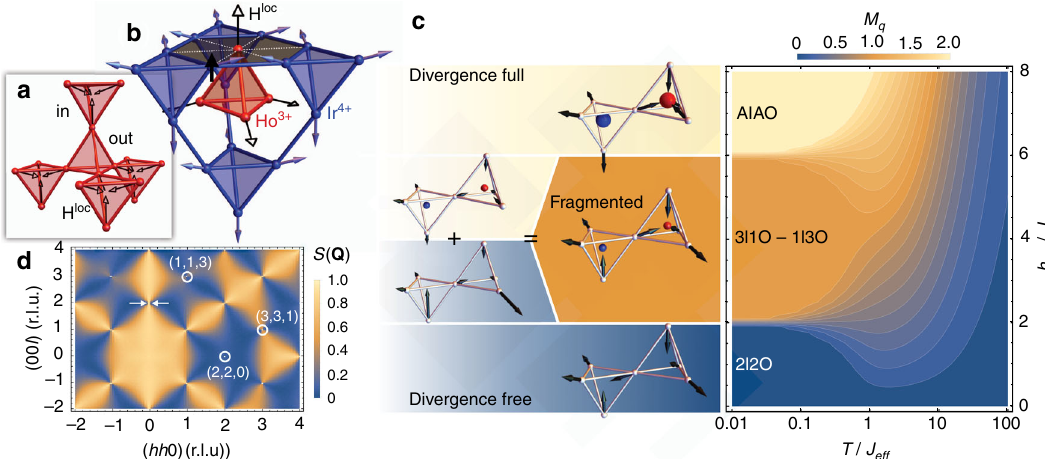
Fig. 1 Staggered fi eld in a pyrochlore lattice and magnetic fragmentation. a Pyrochlore lattice submitted to 〈 111 〉 staggered fi eld represented by the arrows on each site, with in and out tetrahedra when this fi eld points either inward or outward of the tetrahedra. b Structure of the pyrochlore iridate Ho 2 Ir 2 O 7 with the Ho 3+ ions ( red ) and the Ir 4+ ions ( blue ), both occupying a pyrochlore lattice. Each rare-earth is surrounded by a hexagon of six Ir nearest neighbors. When the iridium lattice orders magnetically in the AIAO phase, as shown on the blue lattice , a local magnetic fi eld, perpendicular to the hexagon plane, hence aligned along the local 〈 111 〉 directions, is felt by the central rare-earth ion, as represented in a . c Phase diagram as a function of reduced temperature T = J eff and local fi eld h loc = J eff , de fi ned through the charge order parameter M q ¼ 1 tetrahedra and Δ α = +1 ( − 1) for in (out) tetrahedra carrying a charge q α . As h loc = J eff increases, the ground state changes from the spin ice ( M q = 0, blue ), to the AIAO state ( M q = 2, yellow ), going through the charge crystal intermediate phase which fragments ( M q = 1, orange ). The fragmentation can be described by the splitting of the pseudo-spin σ = ± 1: the divergence free fragment on a tetrahedron can then be written as a state with four spins such that σ = ( ± 1/2, ± 1/2, ± 1/2, and ∓ 3/2), while the divergence full fragment that carries the magnetic charge corresponds to an AIAO con fi guration with q j jh i¼ 0 half of the moment so that σ q j jh i¼ 1 = ( ± 1/2, ± 1/2, ± 1/2, ± 1/2) 8 . All the spin and charge con fi gurations are shown in the left panel of c at T = 0. d Magnetic scattering function S ( Q ), with Q the scattering vector, calculated in the fragmented phase. It shows a diffuse pattern with pinch points (evidenced by arrows ) together with the magnetic Bragg peaks ( highlighted by circles ) characteristic of the AIAO ordered state, but whose intensity (proportional to the magnetic moment squared) is a quarter of that expected when the whole magnetic moment is